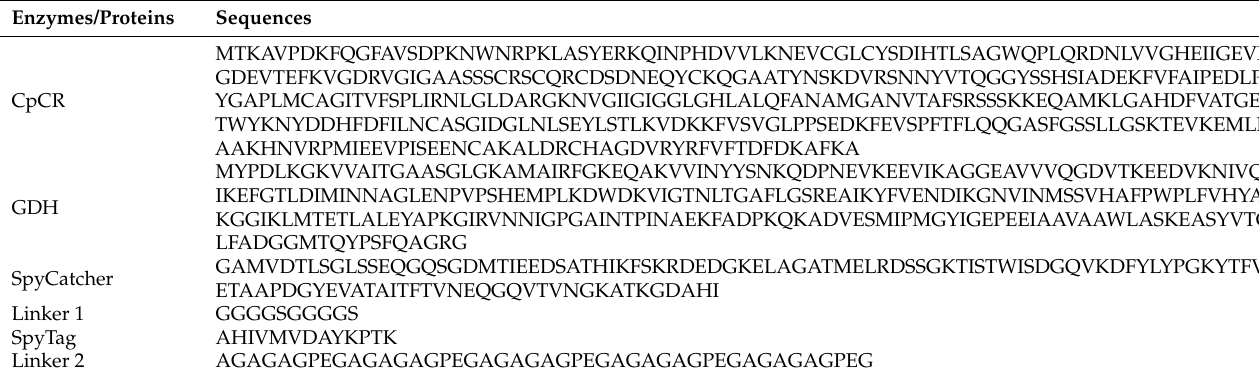
Table 4. Protein sequences in this